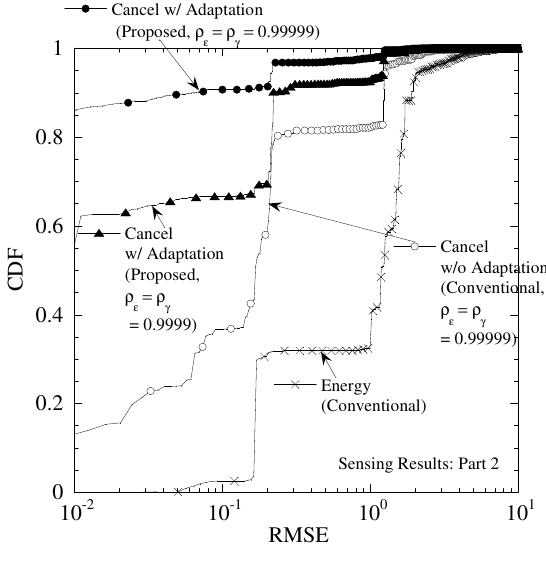
Figure 14. CDF of RMSE in temperature sensor of Part